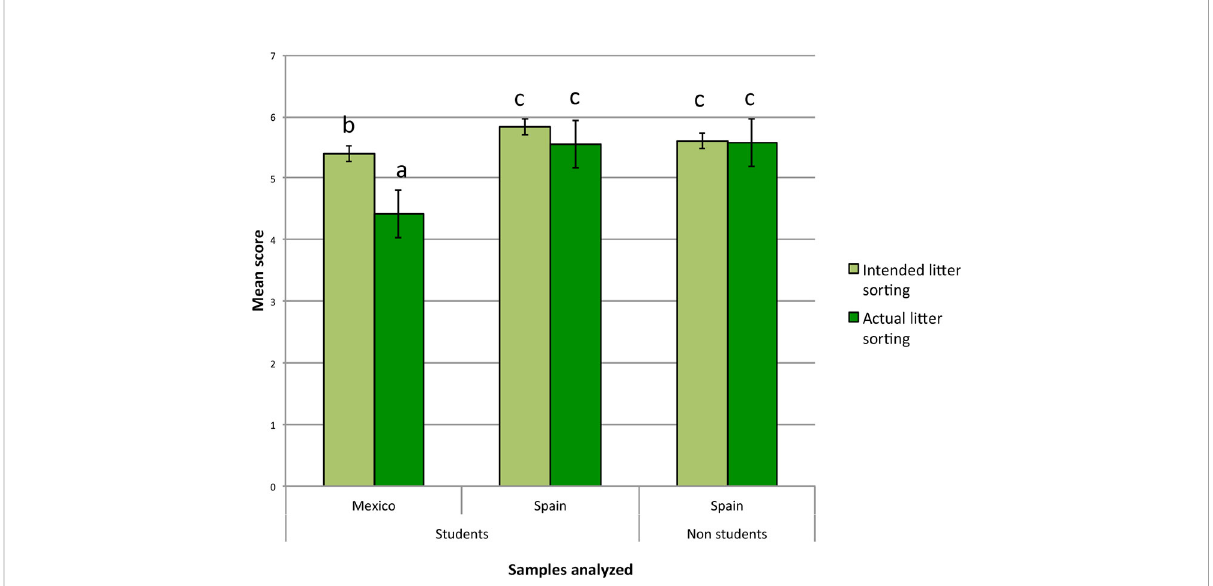
TABLE 3 Summary of signi fi cant predictor variables of pro-environmental behaviors found from multivariate multiple regression models in the three samples analyzed. Sea frequentation Feeling responsible for the sea Gender Age Education Income